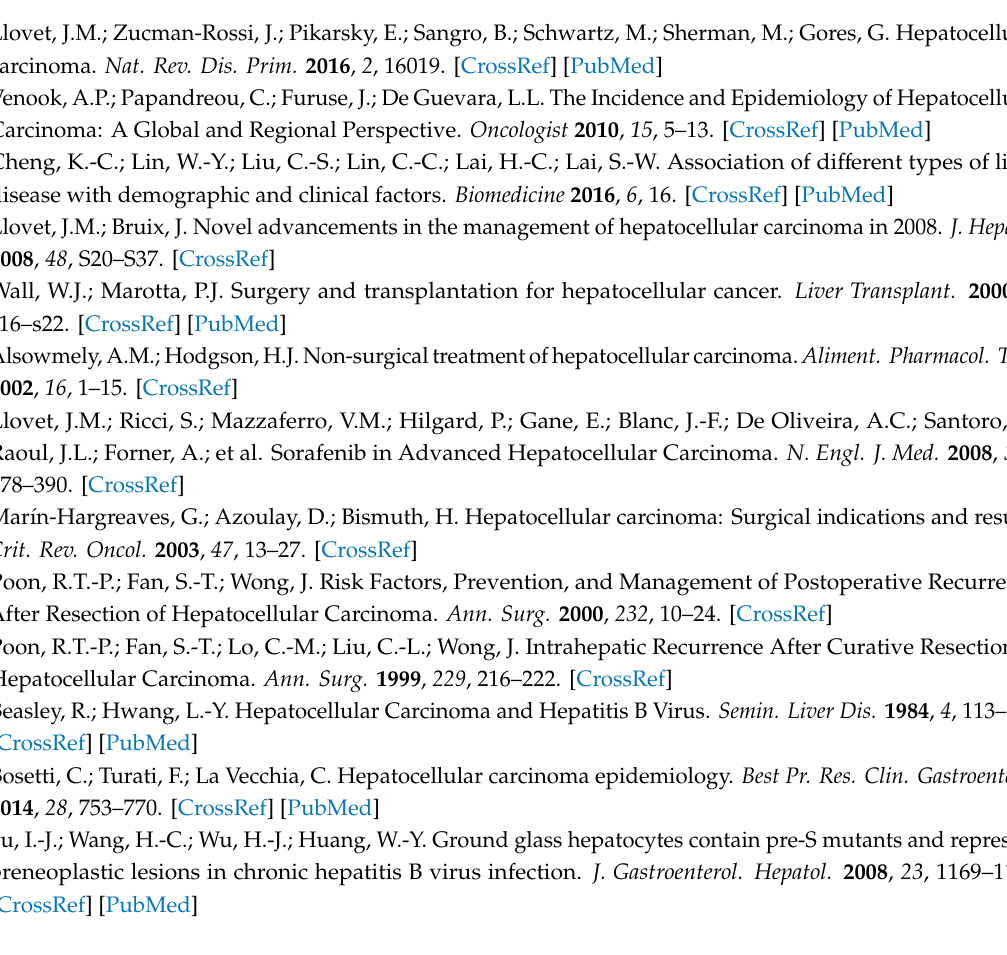
Figure S1: Kaplan-Meier curves of OS and RFS di ff erences in the 75 HBV-related HCC patients after surgical resection, Figure S2: Kaplan-Meier curves of OS di ff erences in the 75 HBV-related HCC patients after surgical resection, Table S1: List of the pre-S genotyping results by TA cloning- and NGS-based analyses in 75 HBV-related HCC patients, Table S2: Univariate and multivariate analyses of pre-S deletion type for overall survival in 75 HBV-related HCC patients, Table S3: Univariate and multivariate analyses of pre-S deletion percentage for overall survival in 75 HBV-related HCC patients, Table S4: Univariate and multivariate analyses of combined pre-S deletion for overall survival in 75 HBV-related HCC